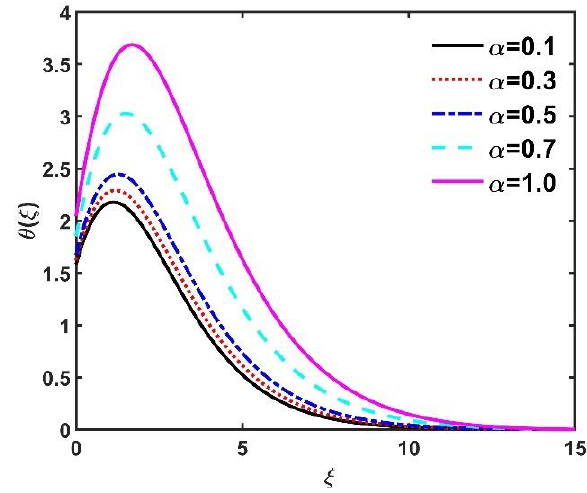
Figure 5. Impact of 𝛼 on 𝜃(𝜉)